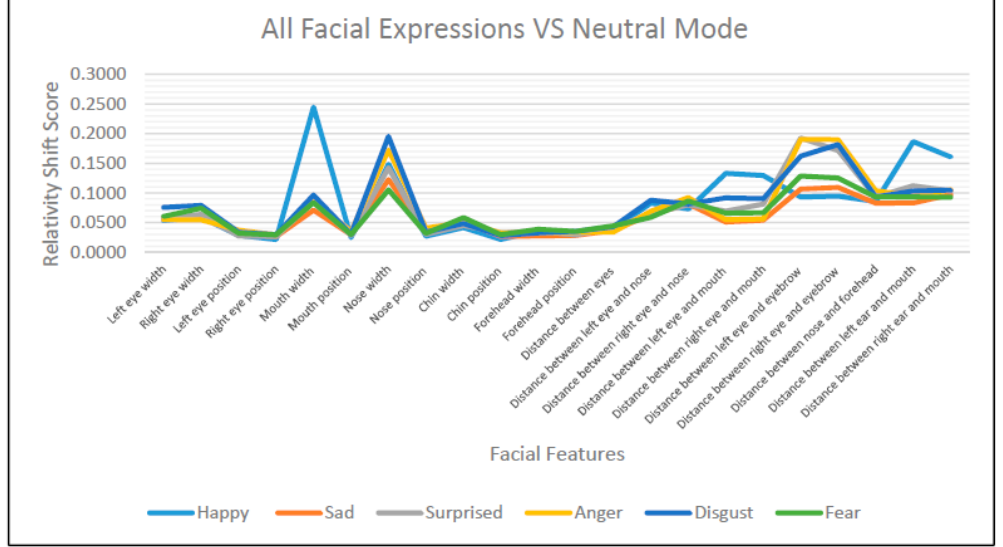
Figure 22. The mean of RSS of 22 facial features for 36 subjects on all expressions. Table 11. The mean of RSS of 22 facial features for 36 subjects on all